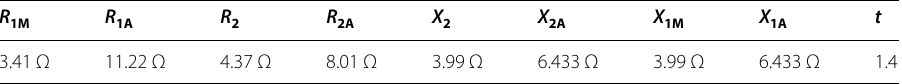
Table 1 Equivalent circuit parameters of the TWSPSEIG R 1M